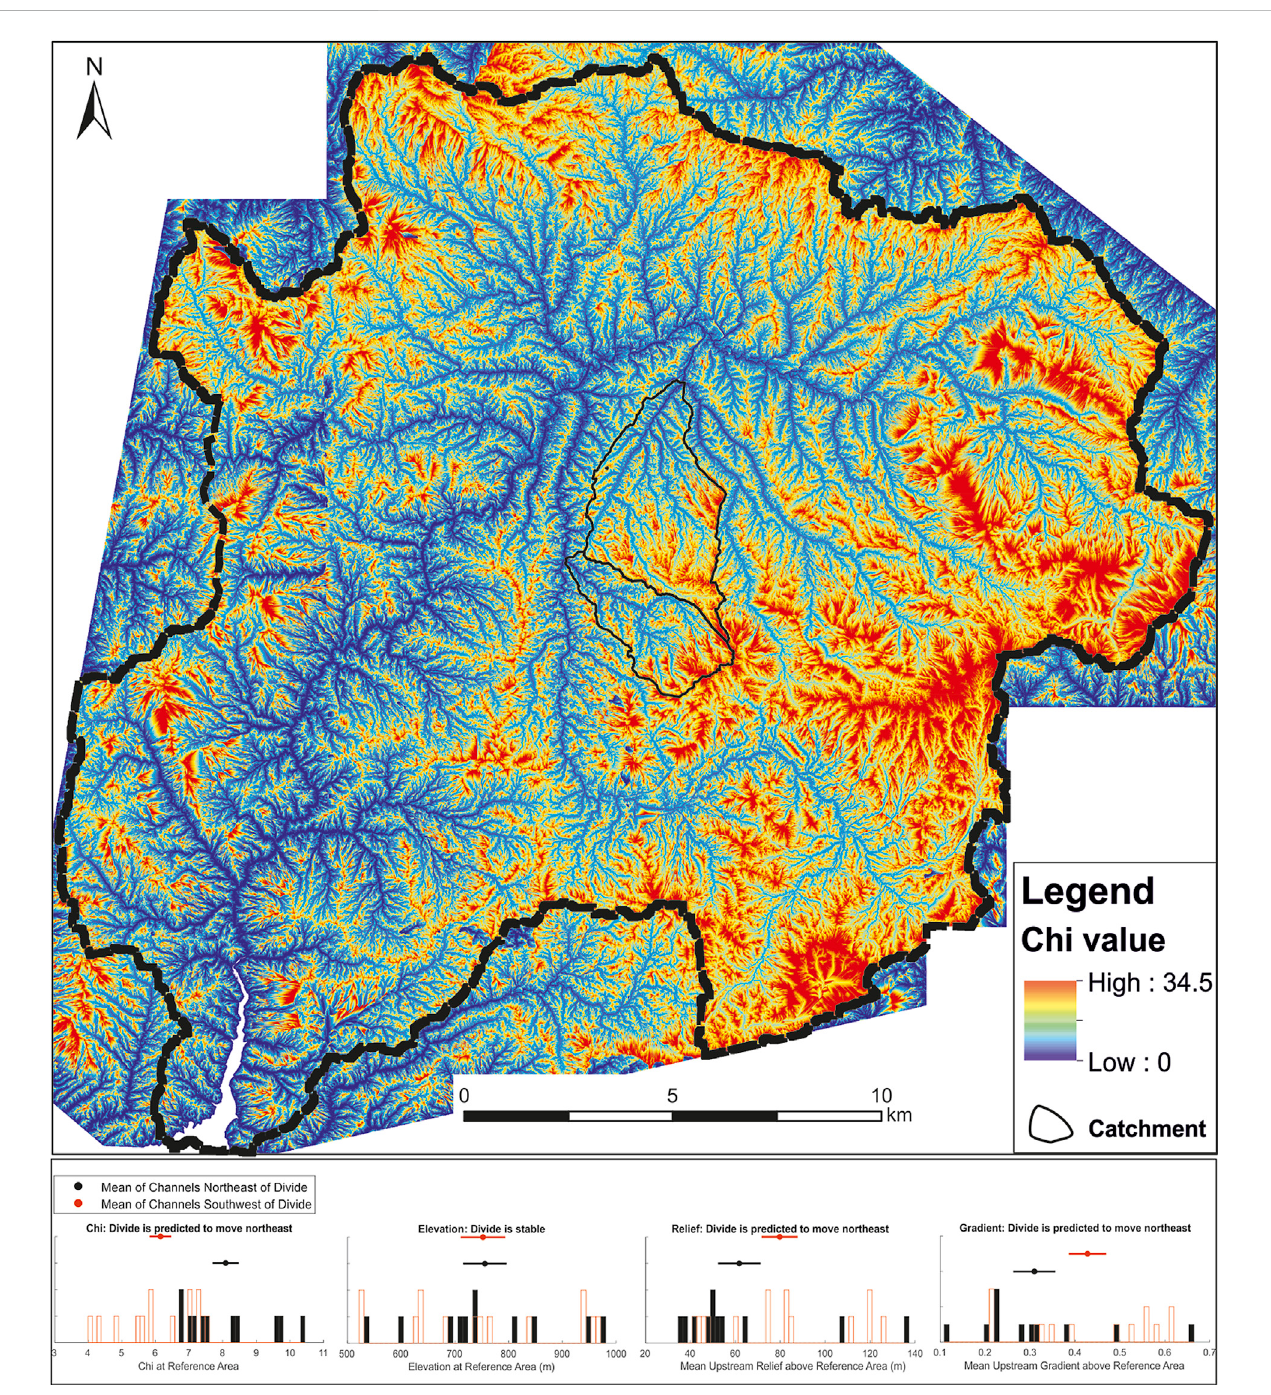
FIGURE 9 Chi map of the Mercure River basin and divide metric histograms for the Torrente Incugnatore and Fosso di Carlomagno catchments. Note the higher difference of Chi values along the divide of the two catchments.